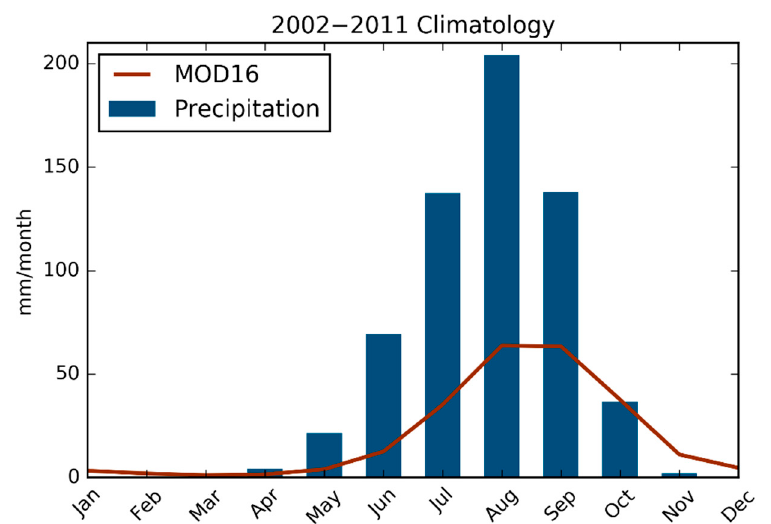
Figure 2. Long-term climatologies of monthly evapotranspiration and precipitation for the Senegal River basin. Precipitation data are based on CHIPRS 2.0 and evapotranspiration data are retrieved from MODIS’ MOD16A2.006 product.